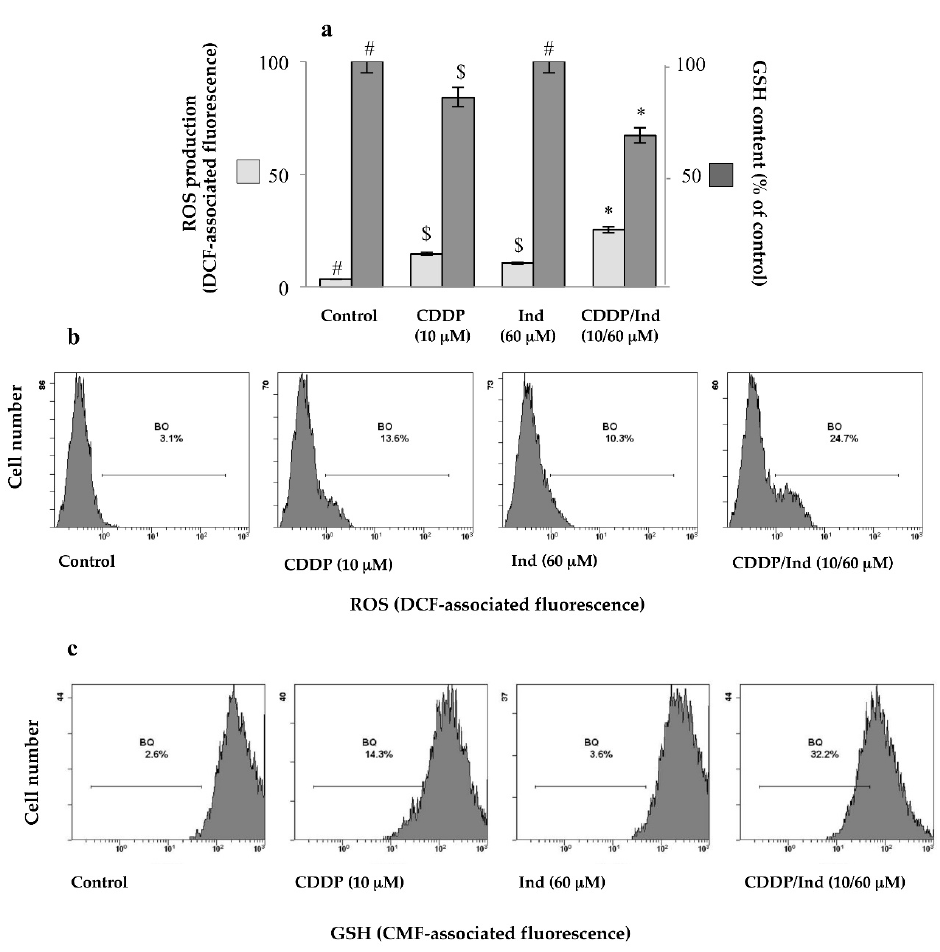
Figure 8. Cell redox unbalance induced in HeLa by CDDP, Ind and CDDP/Ind combination. ROS production and GSH levels were evaluated cytofluorimetrically after 24 h treatment by staining of the cells with DCFDA and CMFDA, respectively. compared to untreated cells (control). ( a ) Mean values symbol are significantly different with p < 0.05 (one-way Anova associated with Tukey’s post hoc